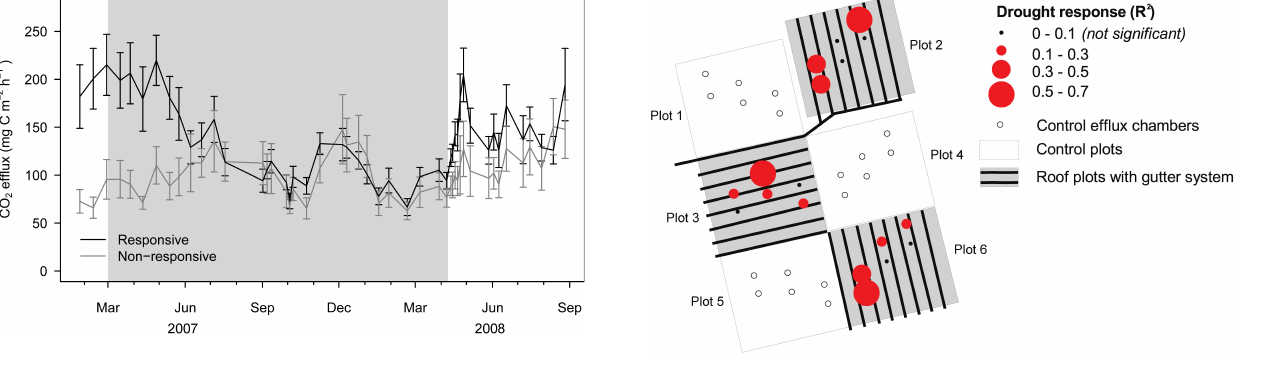
Fig. 3. Schematic of cacao agroforestry plot layout and response of CO 2 flux chambers to soil water content changes. The coefficient of determination ( R 2 ) for the CO 2 efflux to volumetric water content was used as an index of how strong a chamber reacted to changes in soil